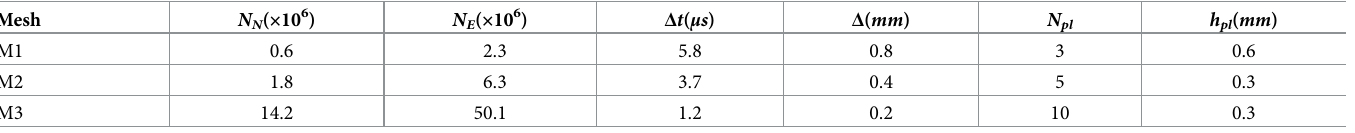
Table 1. Summary of different mesh resolutions and simulation parameters with N Number of prism layers and h pl : Height of total prism